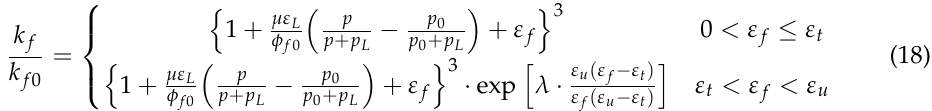
Figure 3. Diagram of damage variable model. Considering to the effect of damage on permeability evolution and referring to Zhu [30] and Ren [31], the exponential item of permeability change induced by damage is incor- porated into original permeability expression, Equation (16). The permeability evolution model is derived under the comprehensive effects of effective stress and damage, which is shown as Equation